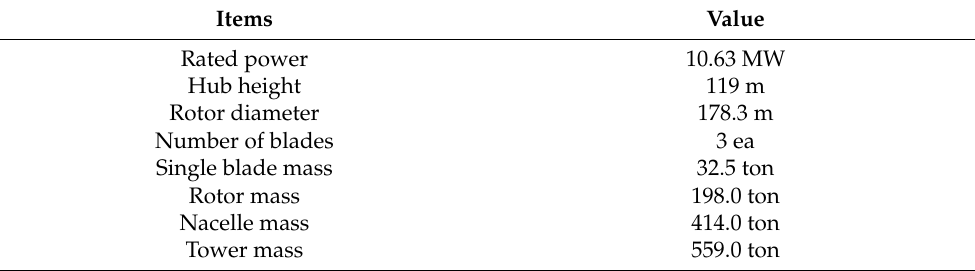
Table 1. Dimensions and weights of the 10 MW FOWT